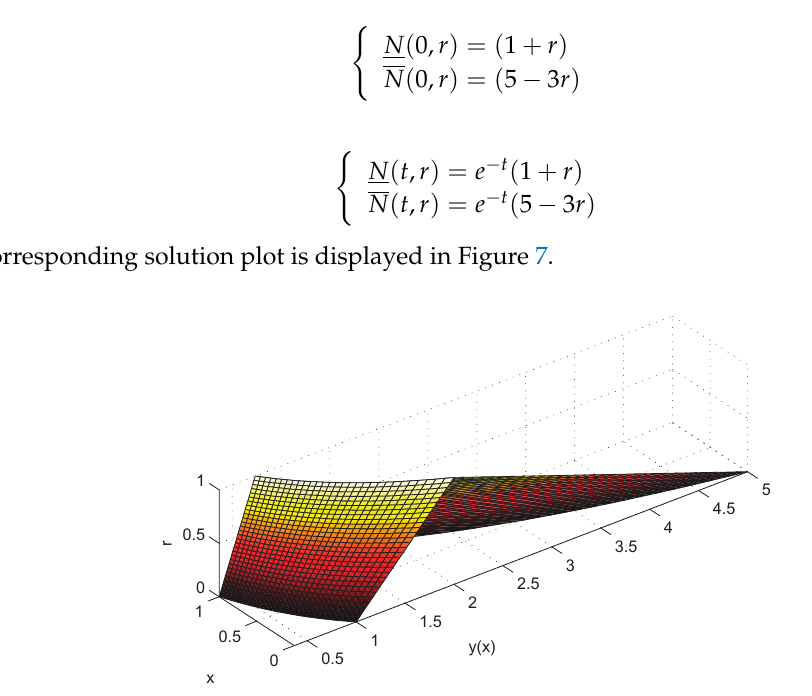
Figure 7. The solution of the nuclear decay equation under case 2